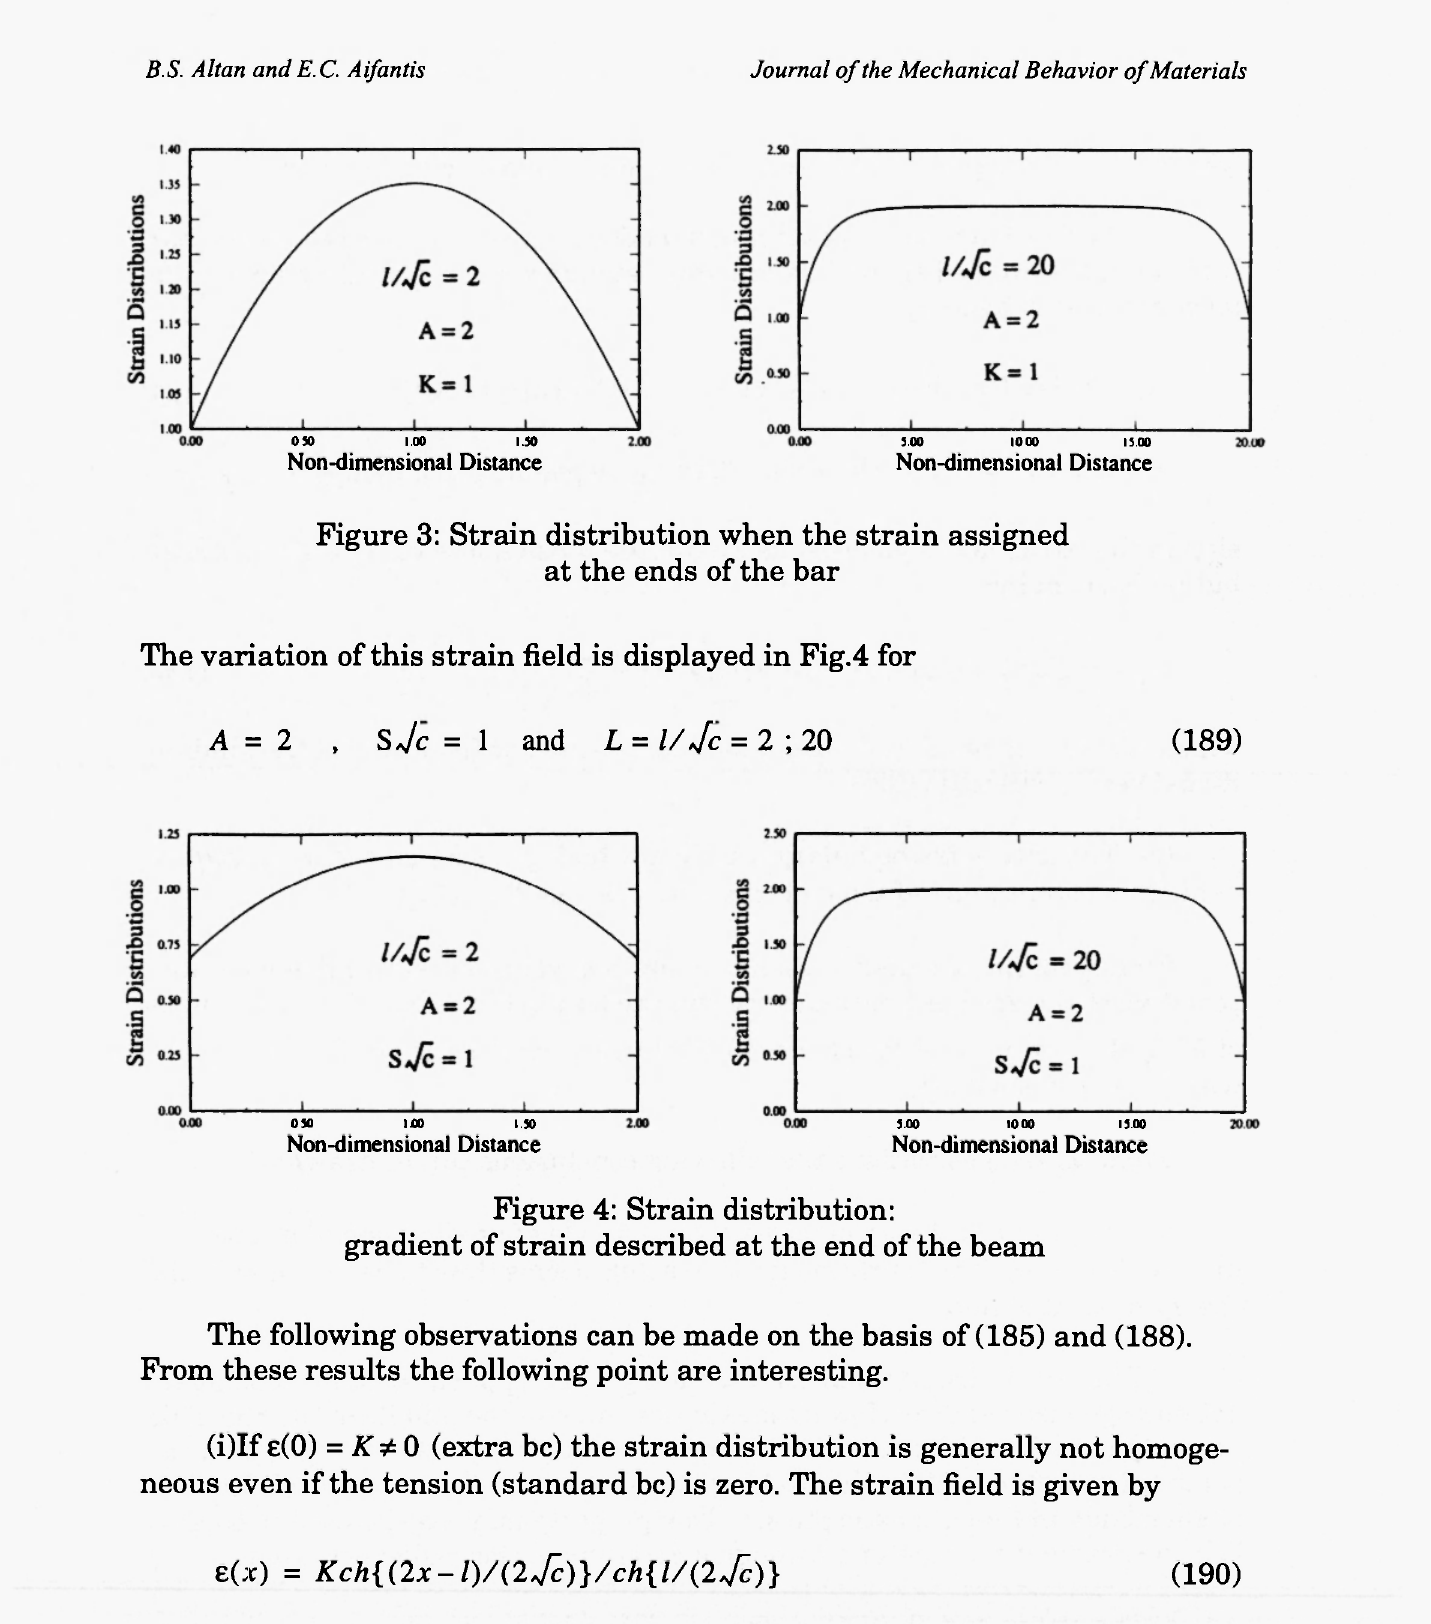
Figure 4: Strain distribution: gradient of strain described at the end of the